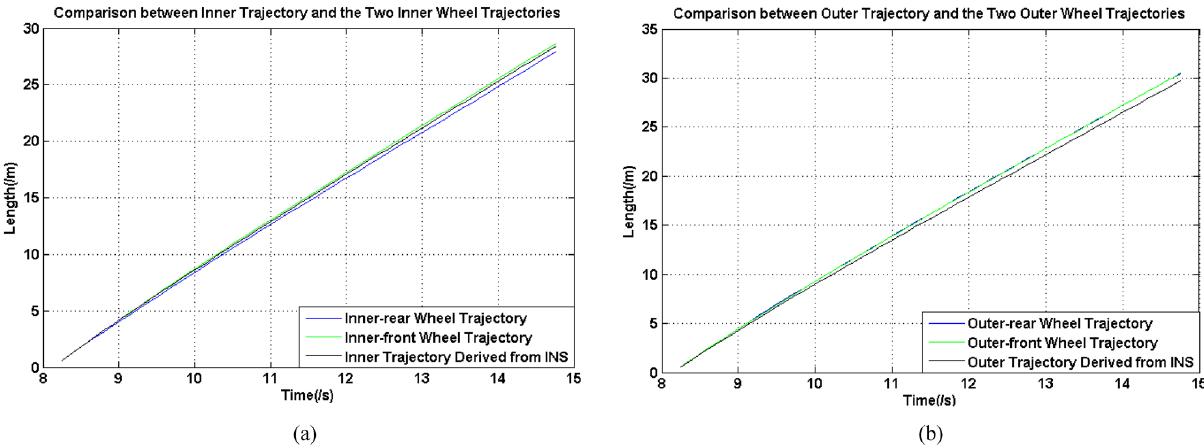
Figure 9. Comparison between trajectories and wheels, ( a ) inner wheels, ( b ) outer moving velocity measured from INS and the two left and right wheels, which were also the inner-rear wheel, inner-front wheel, outer-rear wheel and outer-front wheel under the circumstance. In Fig. 9a and b, the inner and outer trajectories derived from INS were above other two trajectories, so it was so clear to see the variation of their differences with the moving time. According to Table 3 and Fig. 9, the coincidence between the two trajectories of the two inner wheels was lower than those of the two outer wheels, at the same time, the difference between two trajectories of the two inner wheels and the inner trajectory derived from INS was smaller than those of the two outer wheels. These results can also refer to Fig. 7a, the velocity of the inner-rear wheel had an obvious sudden decrease when the turning process started, and at this time, there was an obvious velocity difference in these two wheels, and from this time on, the differences between trajectory lengths gradually increased. Therefore, for these four wheels, their slippage level should be seriously and individually considered. Under these circumstances, this information can be employed to quantitatively evaluate the slippage levels of the four wheels. For each wheel, the slippage level can be calculated using Eq. (17):